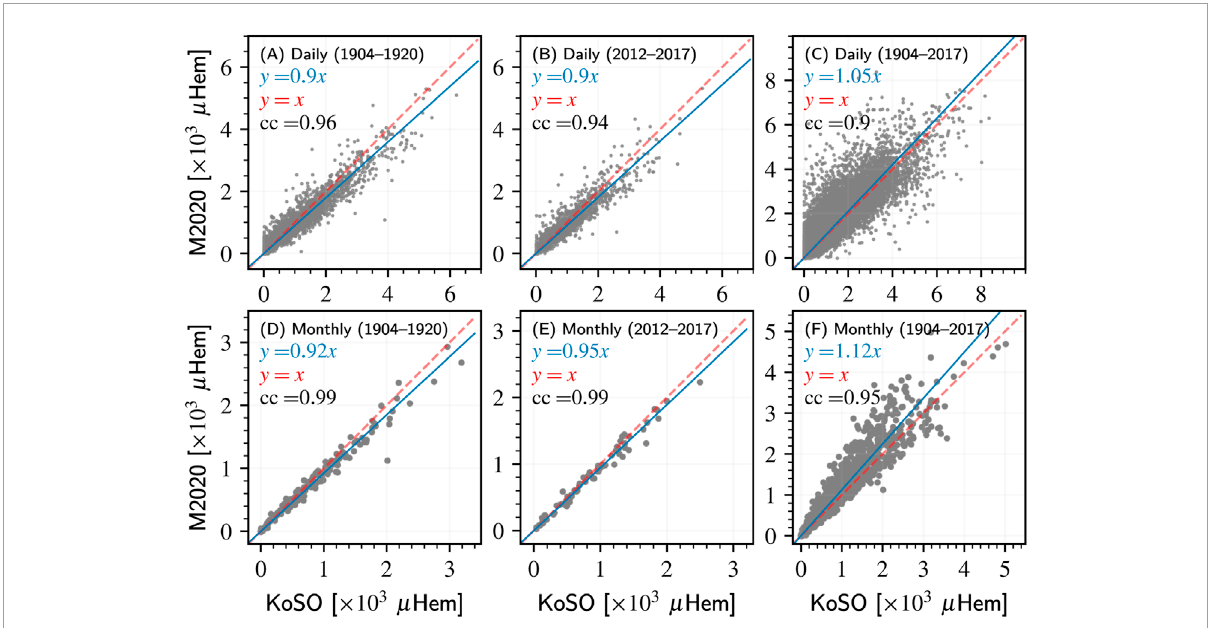
FIGURE 5 The scatter plot showing the comparison of the daily sunspot area, panels (A–C) ; and monthly averaged sunspot area, panels (D–F) with M2020 for 1904–1920, 2012–2017 and for the extended period of 1904–2017. In each panel, the line with unit slop and the linear fit with zero intercepts are represented by dashed red and solid blue lines,